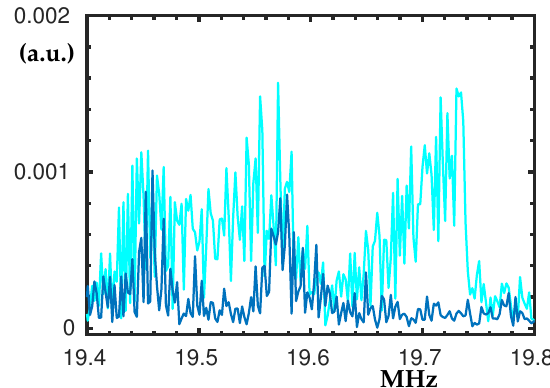
Figure A4. Experimental frequency swipe up centred at about 19.6 MHz for V pp = 18 V, the blue and cyan curves denote V of f = 0 V and V of f = 5 V, respectively.